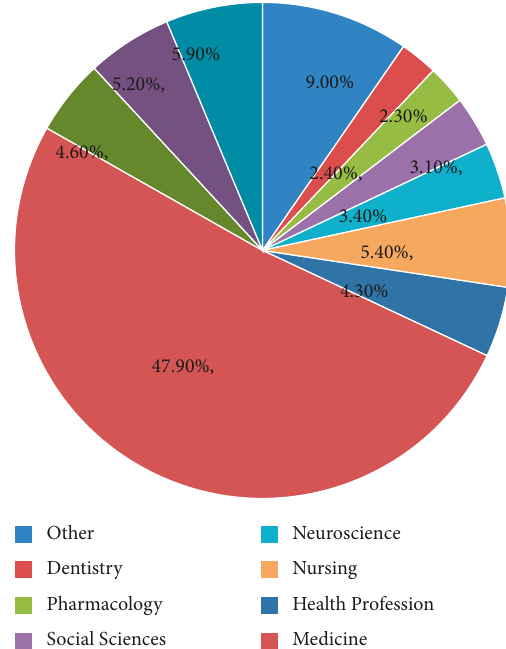
Figure 14: Pie chart depicting article distribution by disciplines for umbrella review articles.